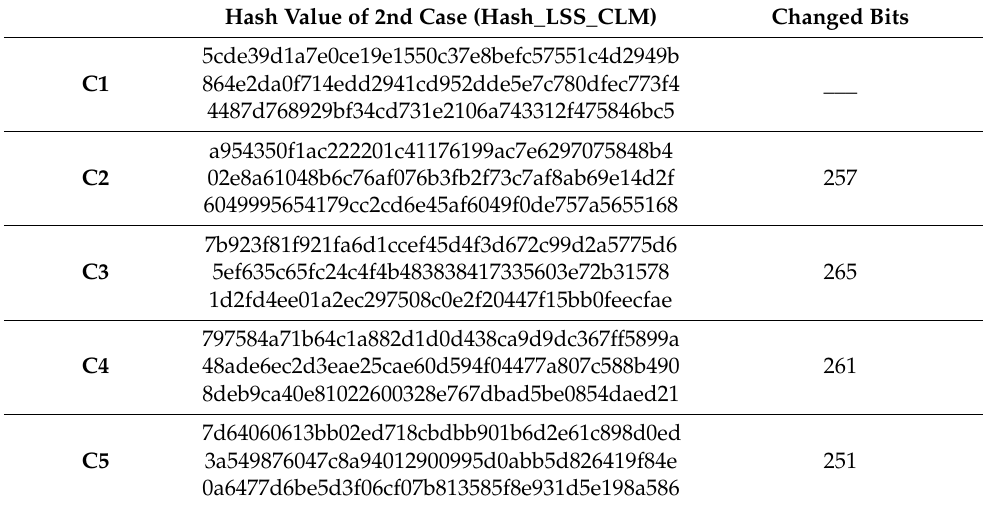
Table 5. Hash values of second structure.